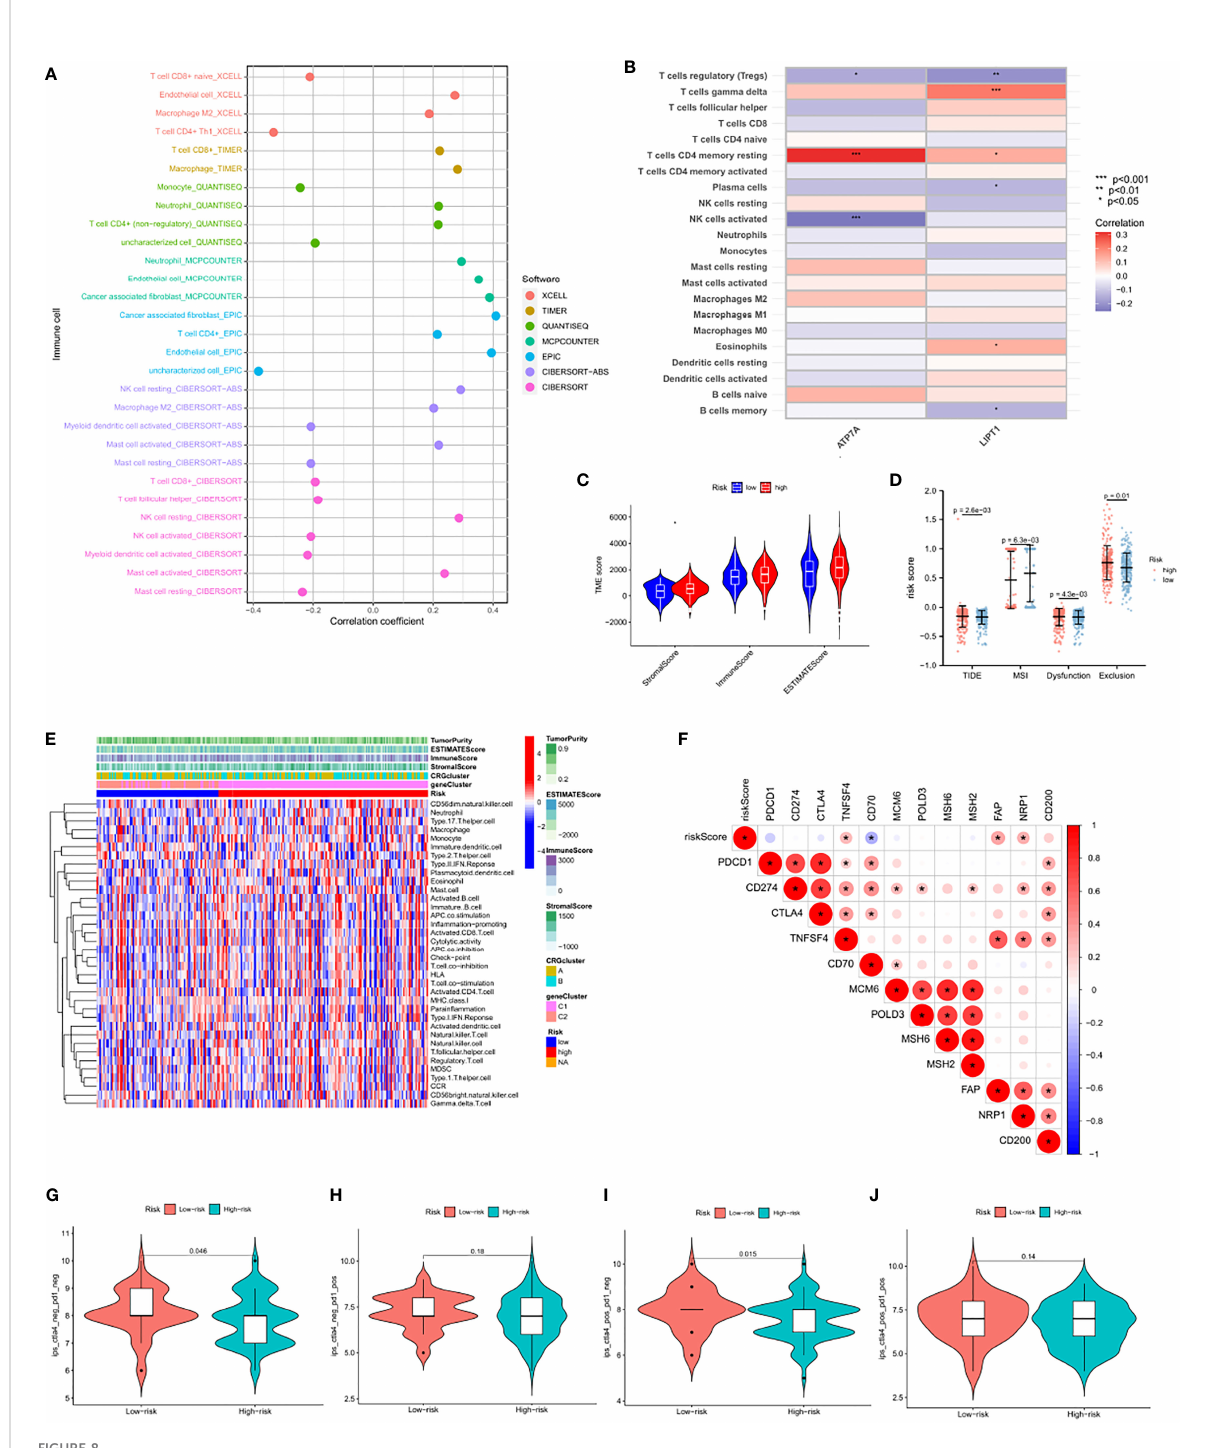
FIGURE 8 Comparison of immune activity between subgroups (A) The immune cell bubble of risk groups (B) Correlations between the abundance of immune cells and 2 genes in the proposed model. (C) Correlations between CRG_score and both immune and stromal scores. (D) Correlations between CRG_score and TIDE, MSI, Dysfunction and Exclusion. (E) Differences in immune scores, stromal scores and expression levels of immune cells between the high-and low-risk group. (F) Correlation of 12 immune checkpoint gene risk scores. (G – I) The association between IPS and the CRGs based on TCIA database, (G) CTLA4 – PD1 – (H) CTLA4 – PD1+ (I) CTLA4+ PD1 – (J) CTLA4+ PD1+. The asterisks represented the statistical p value (*P < 0.05; **P < 0.01; ***P <